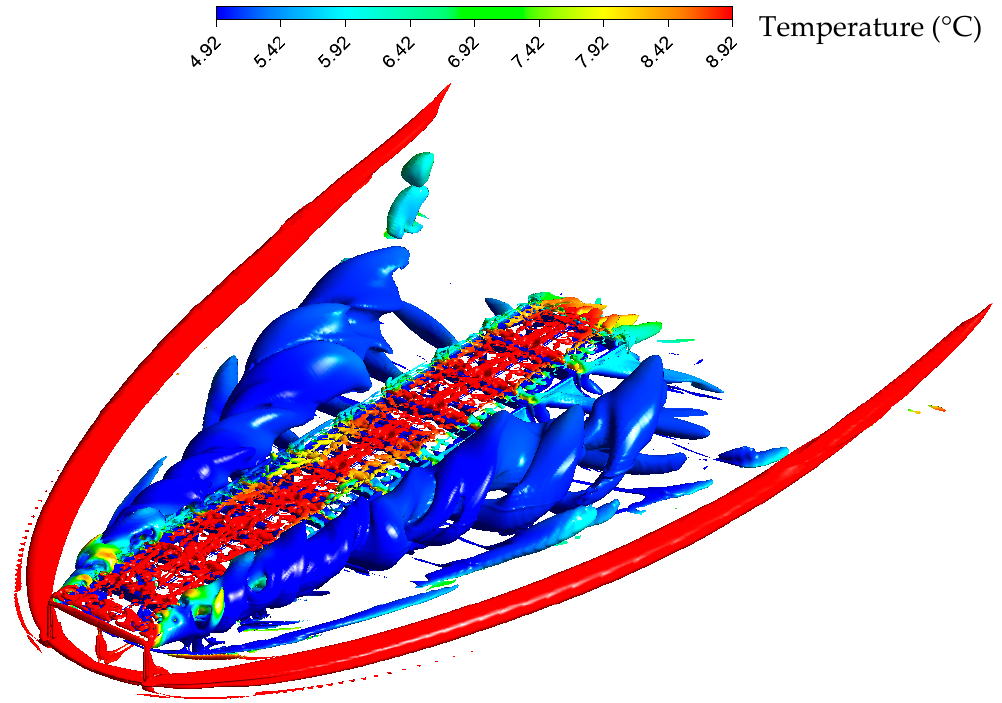
Figure 10. Vortex region of the flow around the evaporators with associated temperature field, uniform field and south wind condition.